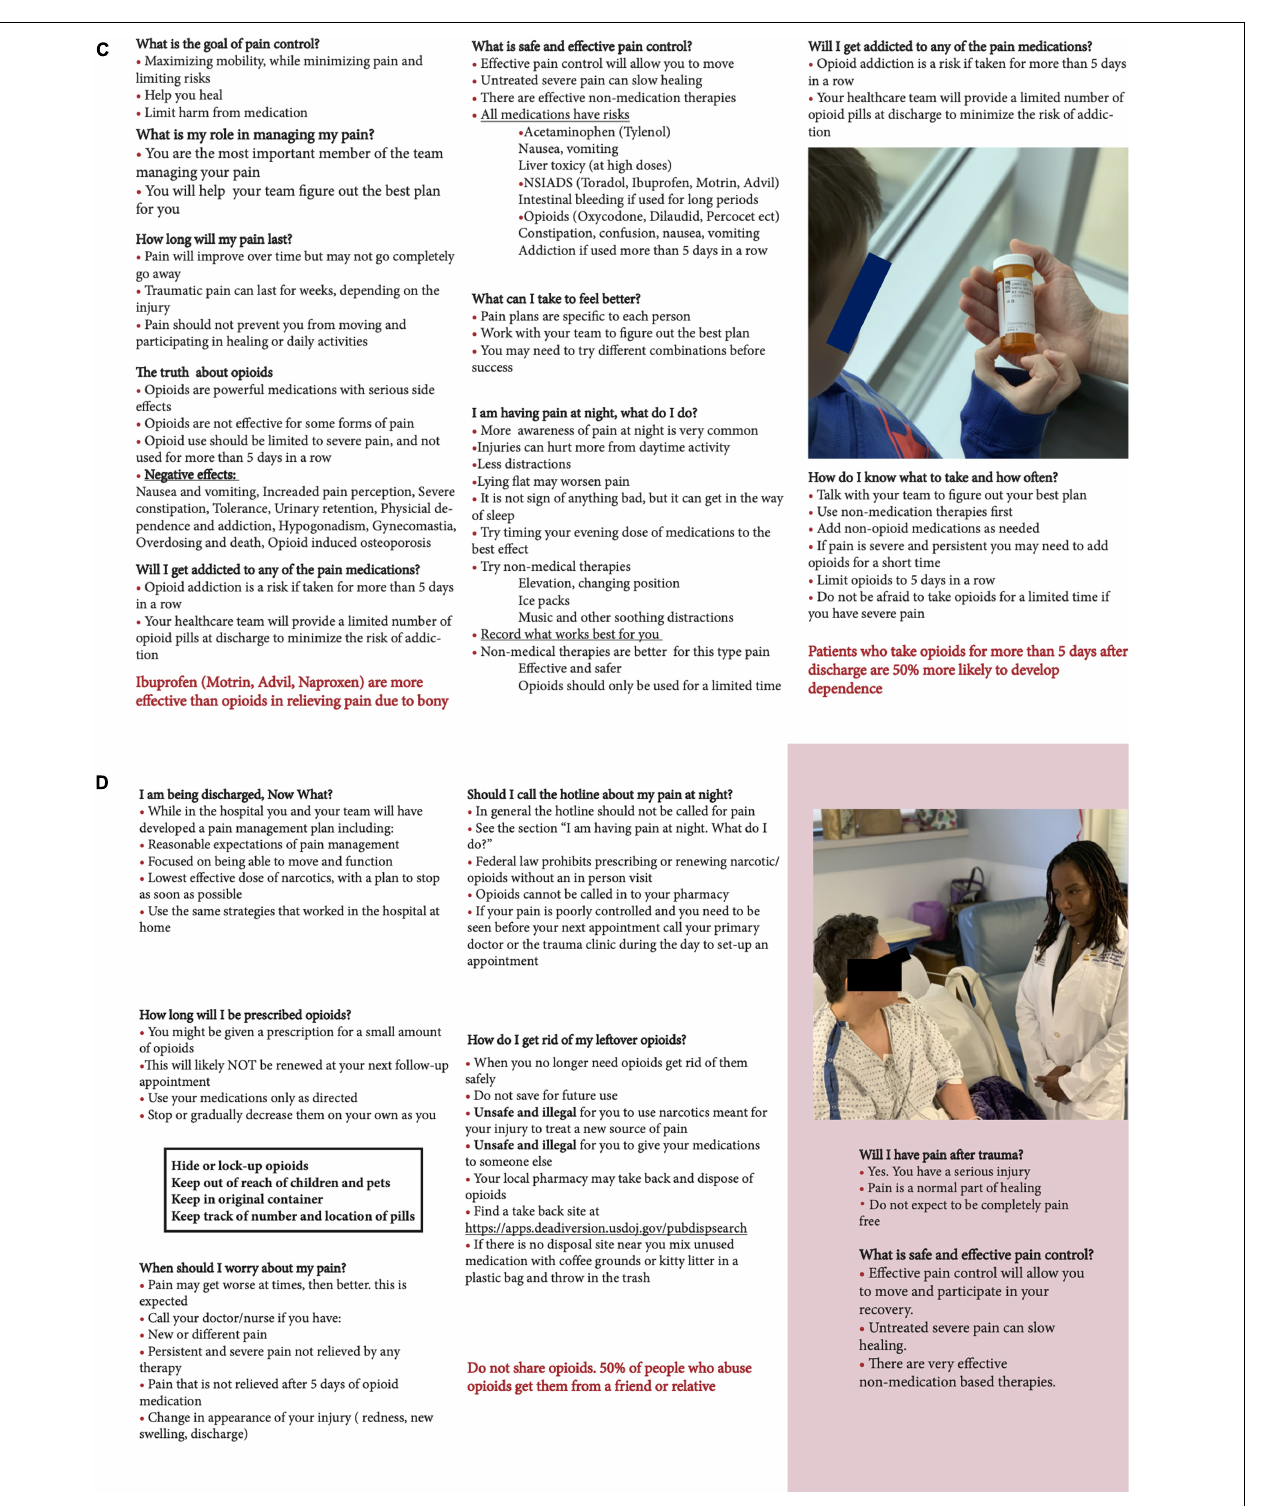
Frontiers in Psychiatry |